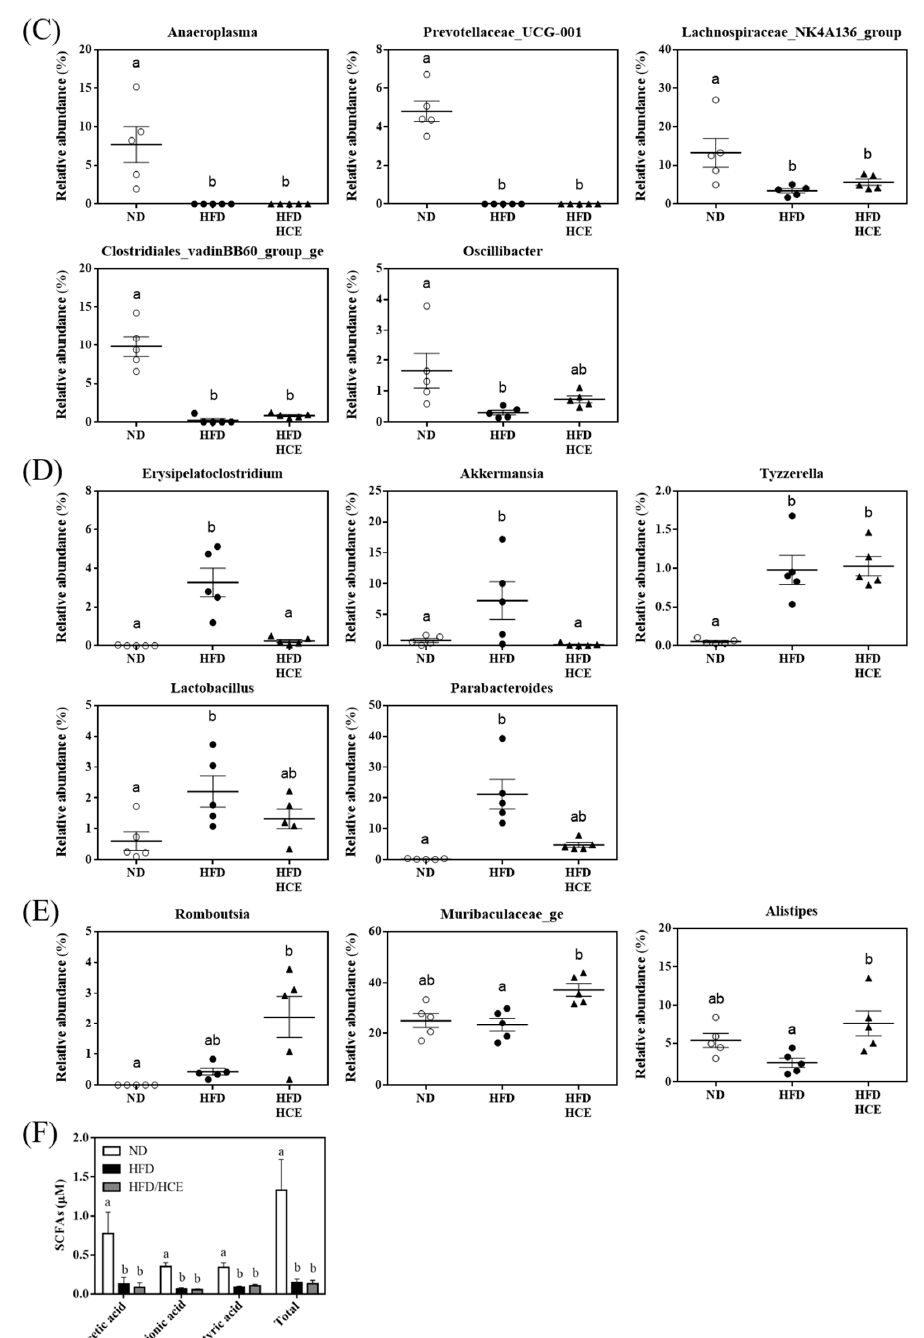
Figure 9. Effects of djulis hull extract on the composition of the gut microbiota in the faeces of high-fat diet-induced hyperglycaemia. Cladogram generated from the linear discriminant effect size (LEfSe) analysis, showing the most differentially abundant taxa enriched in the microbiota of ( A ) ND (red) or HFD (green) and ( B ) HFD (red) or HCE (green). Significantly different abundances in LEfSe comparisons, sorted by p -values in ascending order. ( C ) Compared with the ND group, the bacterial genera decreased in the HFD group. ( D ) Compared with the ND group, the bacterial genera increased in the HFD group. ( E ) Compared with the ND or HFD groups, the bacterial genera increased in the HCE group. ( F ) Short-chain fatty acid production in different groups. The statistical methods used one-way ANOVA, and the values with different letters are significantly different at p <